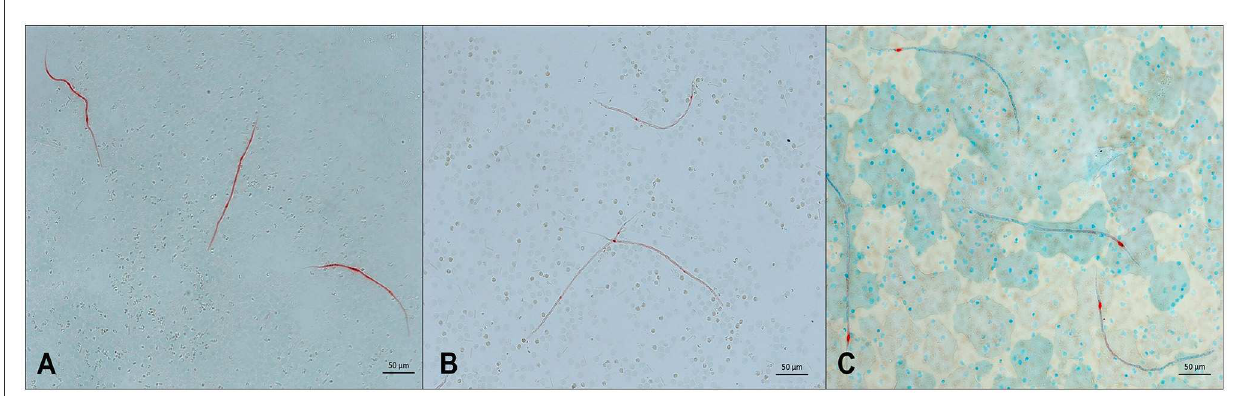
FIGURE4 Microfilariae detected in blood samples stained by acid phosphatase (AP) histochemical method. (A) Acantocheilonema reconditum: AP activity through the entire body (red); scale bar: 50 µ m. (B) Dirofilaria immitis : AP activity in excretory and anal pores (red); scale bar: 50 µ m. (C) Dirofilaria repens : AP activity in anal pores (red); scale bar: 50 µ